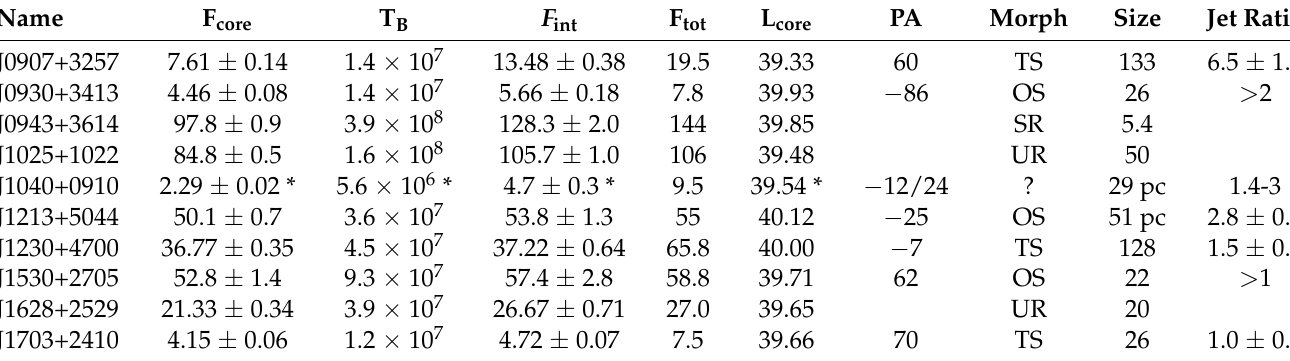
Table 3. Column description: (1) name; (2)–(6) core peak flux density (mJy beam − 1 ), core brightness temperature (K), total core flux density (mJy), and total emission from the entire structure (mJy) and its core luminosity (erg s − 1 ) from EVN maps at 1.66 GHz; (7)–(9) PA (degree), radio morphology (TS, two-sided; OS, one-sided; SR, slightly resolved; UR, unresolved), and size (pc); (10) jet sidedness. For J1040+0910, the core location within the structure is ambiguous, and we mark with * its core flux densities and luminosity, estimated assuming its most southern brightest component as the